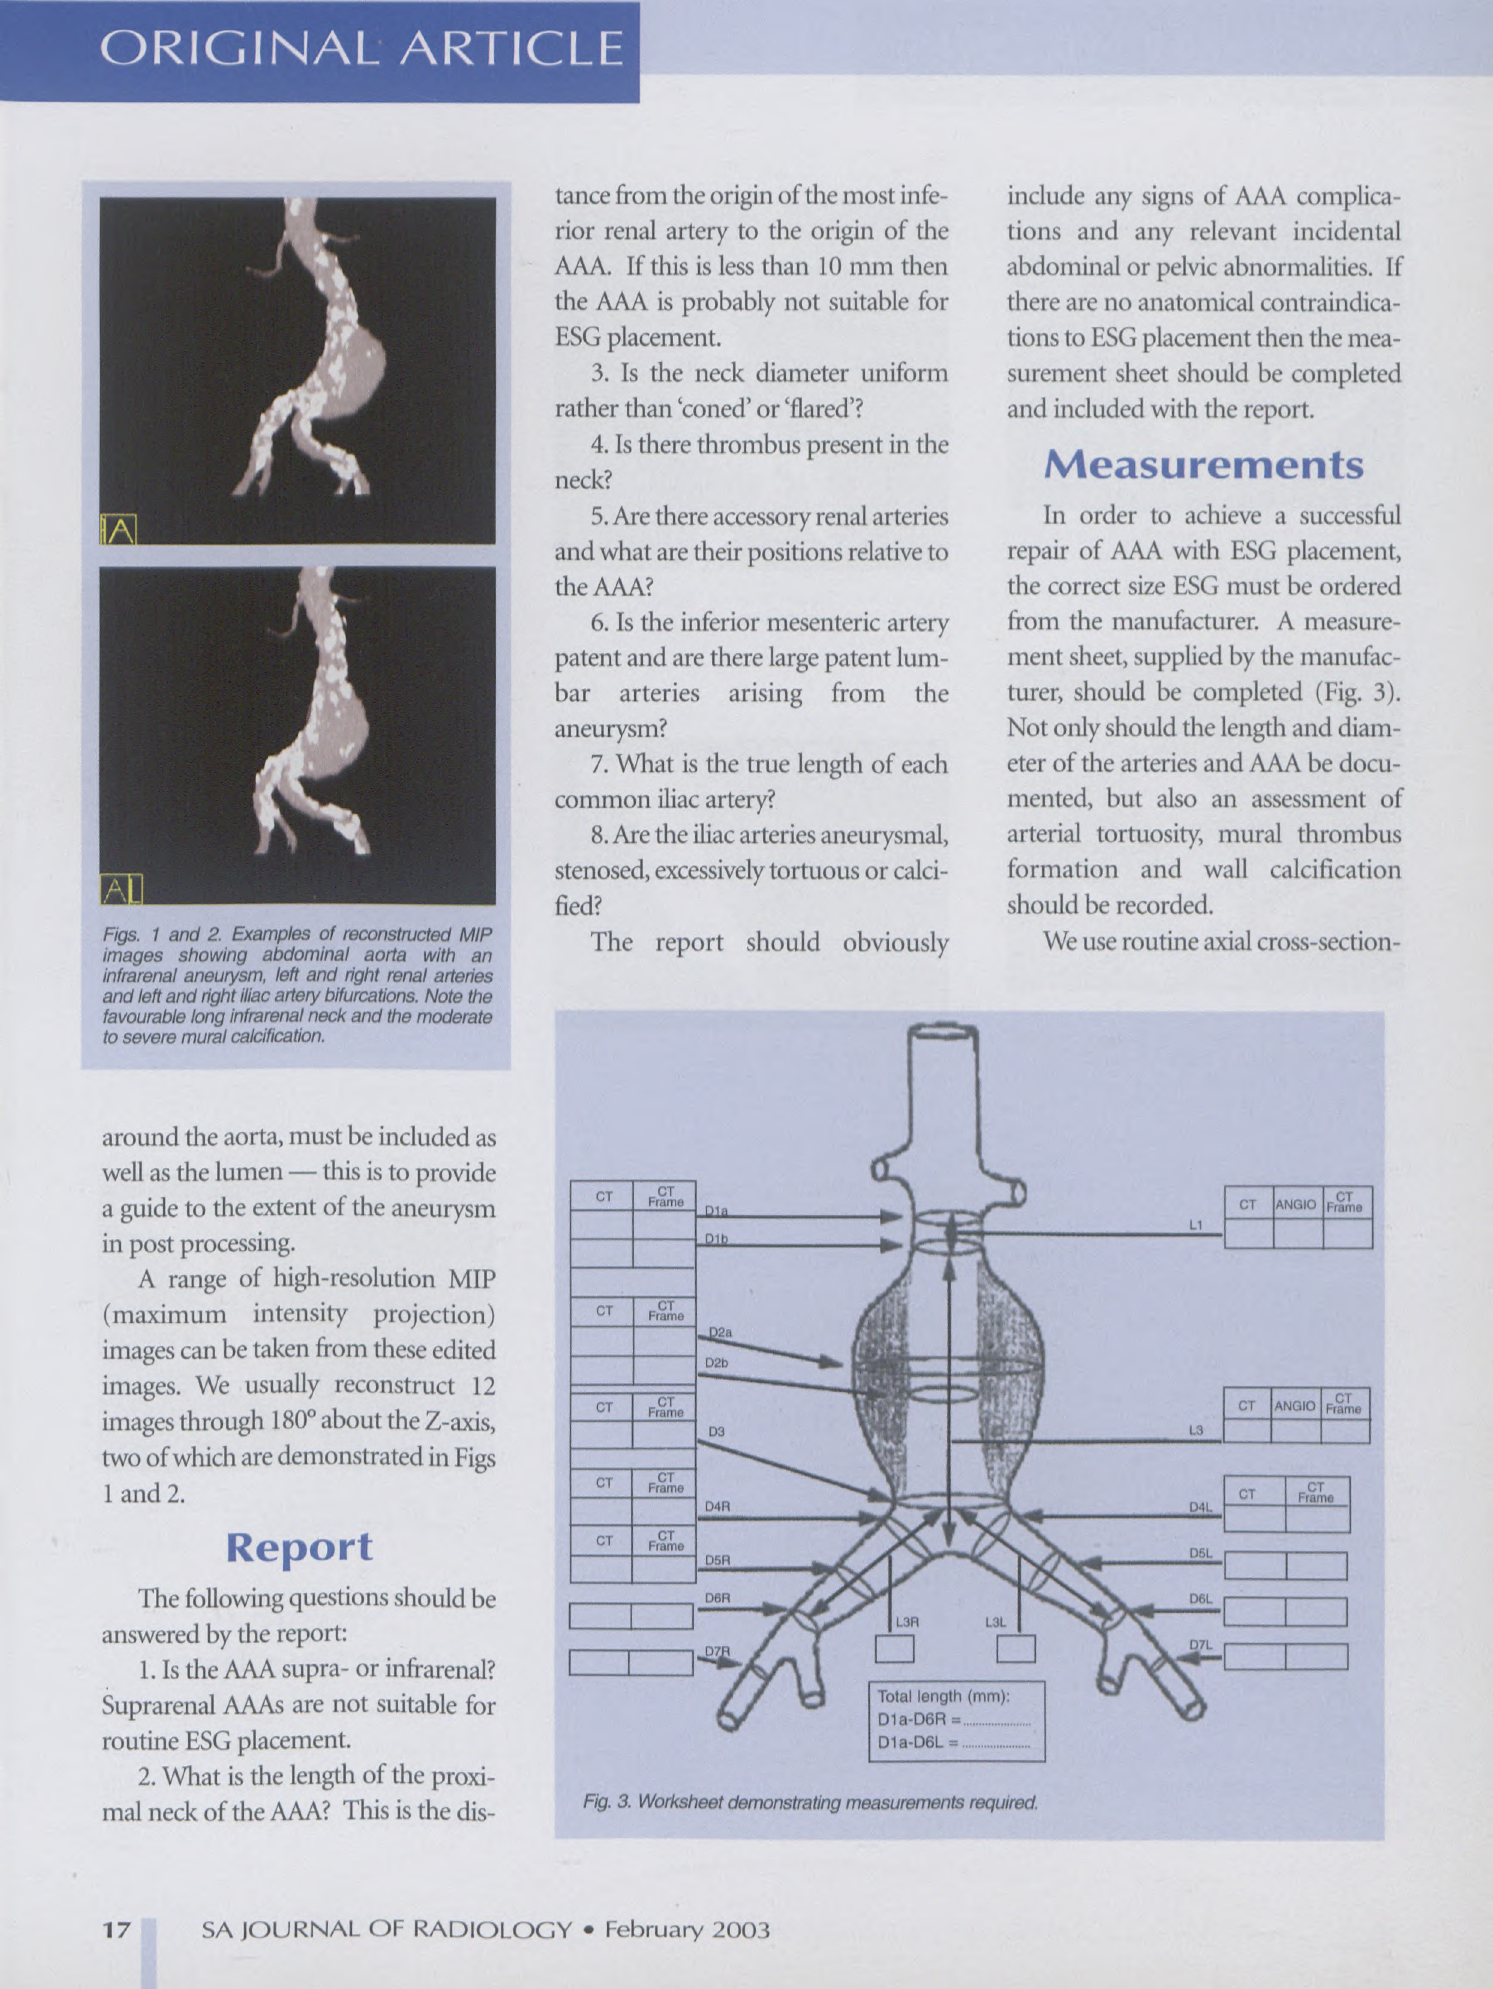
Fig. 3. Worksheet demonstrating measurements